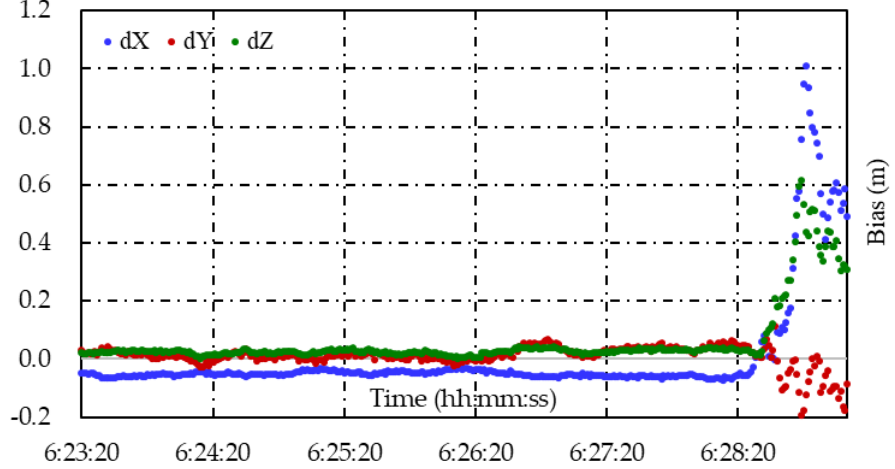
Figure 17. Coordinate biases from kinematic PPP with MSJP correction.